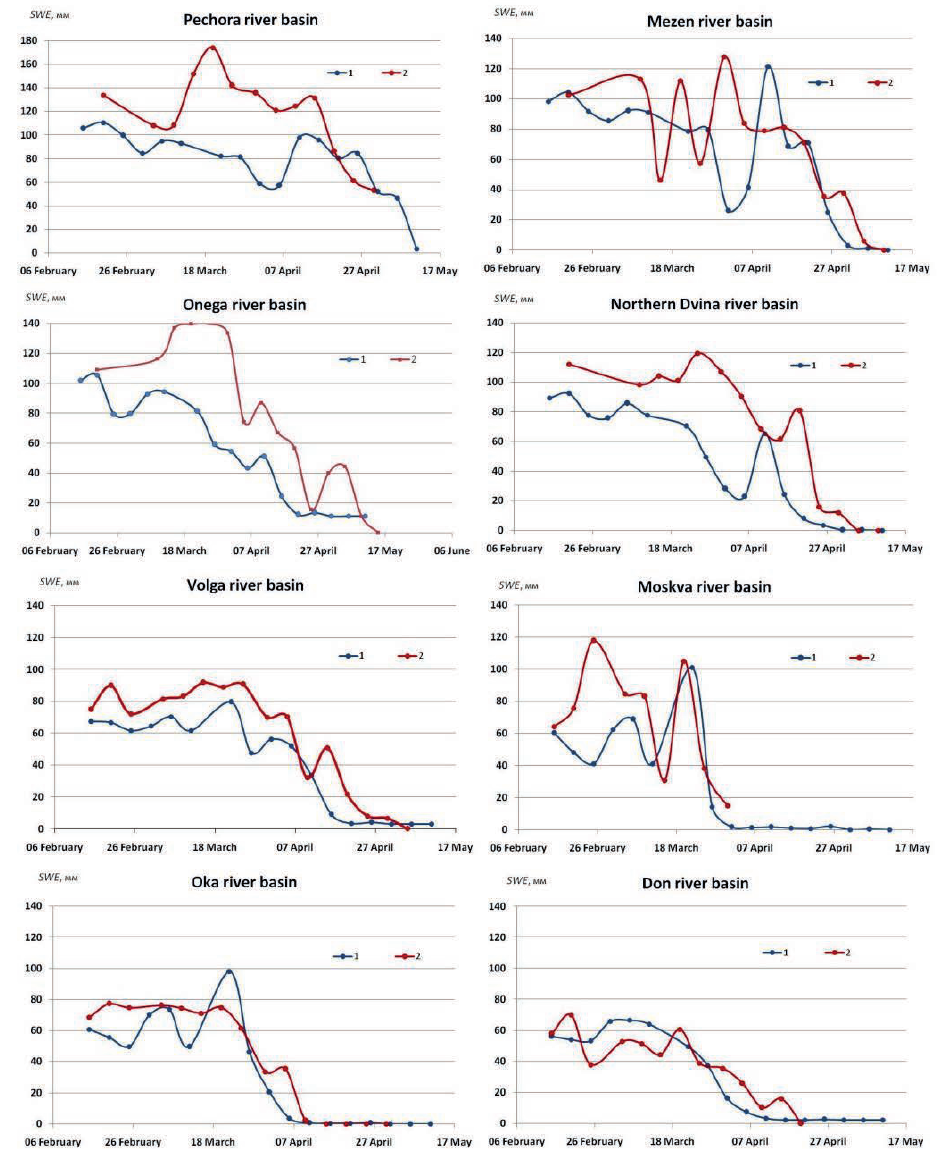
Fig. 1 Comparison of estimated (1) and in situ (2) SWE data values for spring snowmelt period of